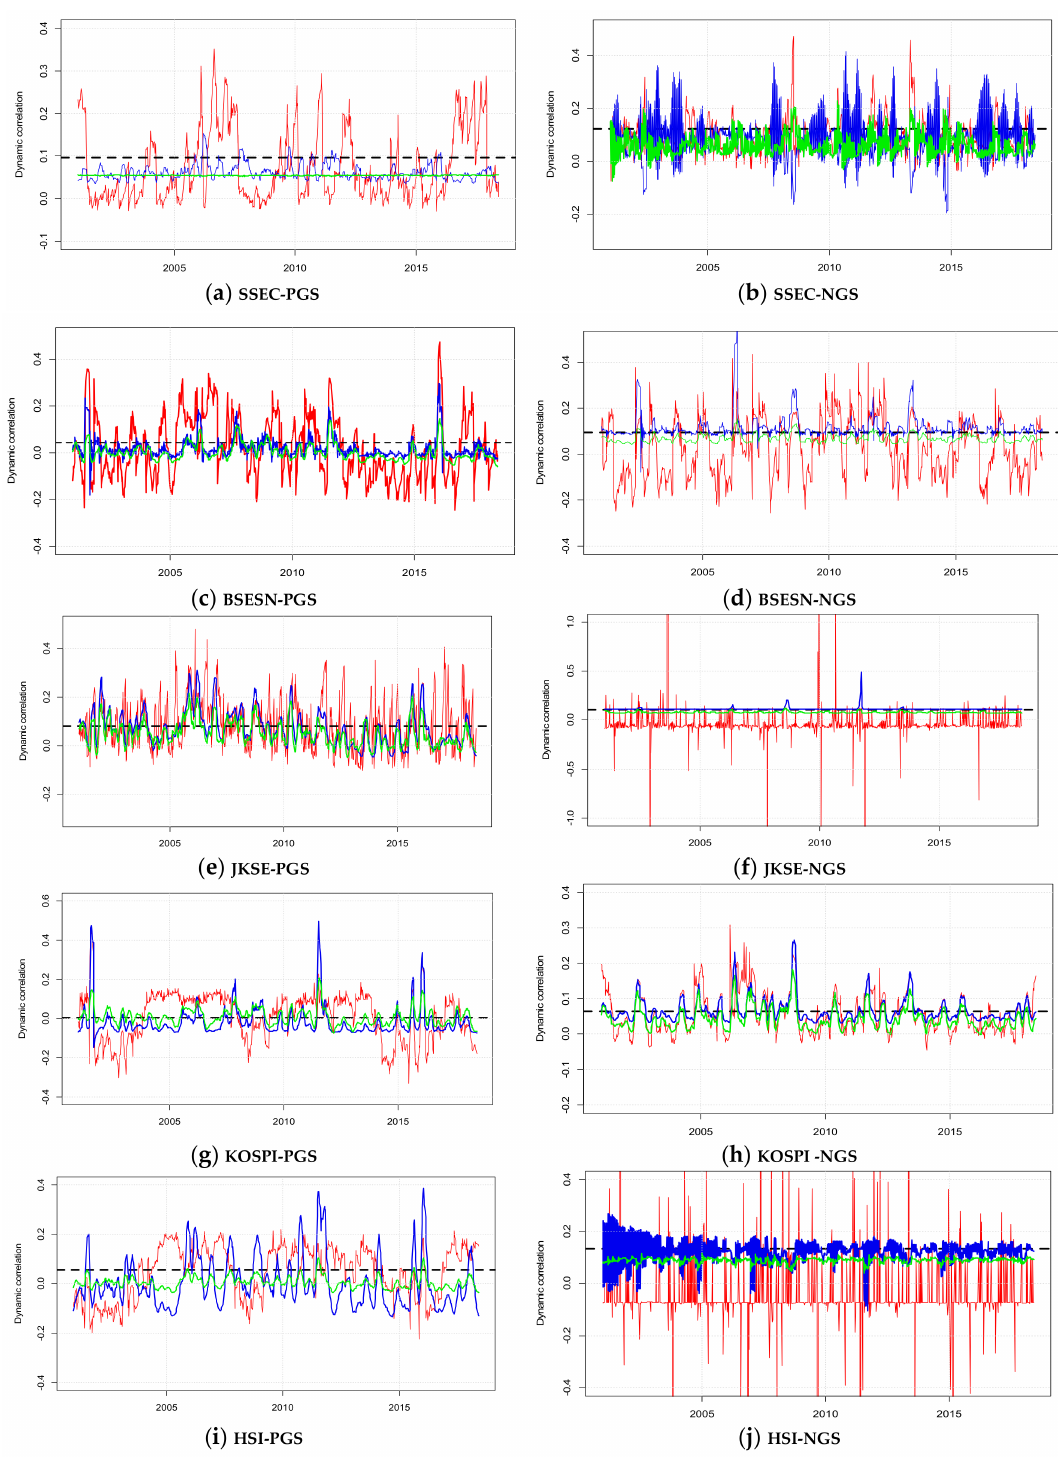
Figure 3. Time-varying Copula dependence measures. The graphs in the left column plot the time-varying Kendall’s tau between stock volatility and positive gold shock, while those in the right column plot the time-varying Kendall’s tau between stock volatility and negative gold shock for SSEC, BSESN, JKSE, KOSPI, and HSI markets: The black dashed line is the Static Copula, the green line is the Dynamic Copula, the red line is the Markov Switching Dynamic Copula (MSDC), and the blue line is the Smooth Transition Dynamic Copula